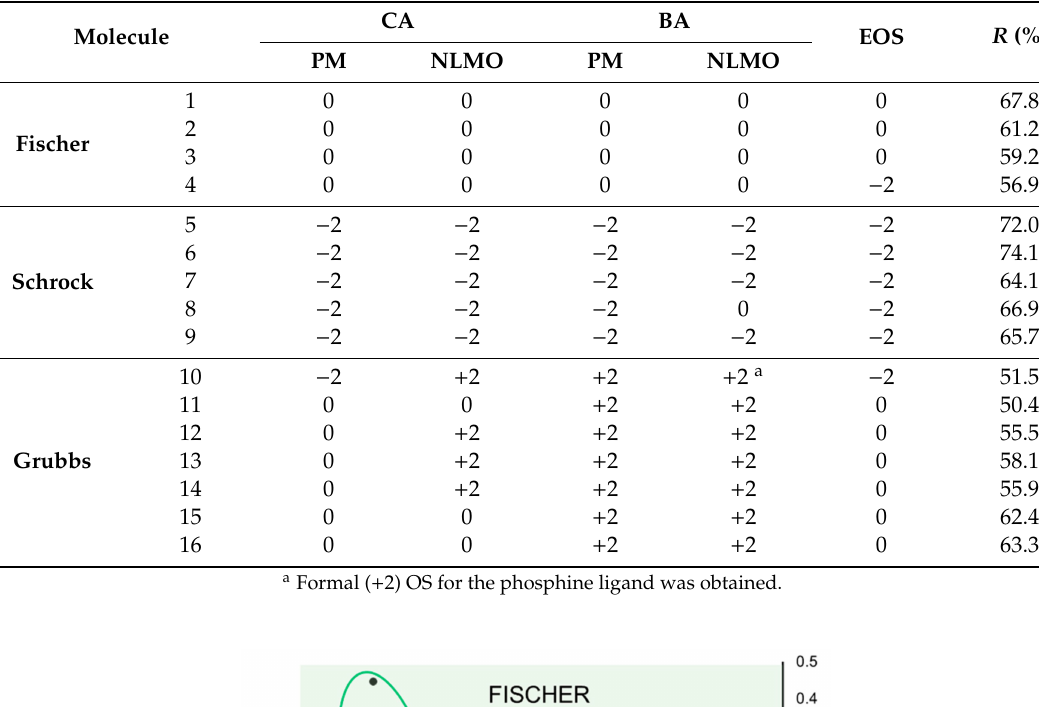
Table 2. Formal OS for the carbene moiety (CR 1 R 2 ) for the set of TM carbene compounds using centroids of localized orbitals (PM and NLMO) combined with CA and BA criteria and EOS analysis.